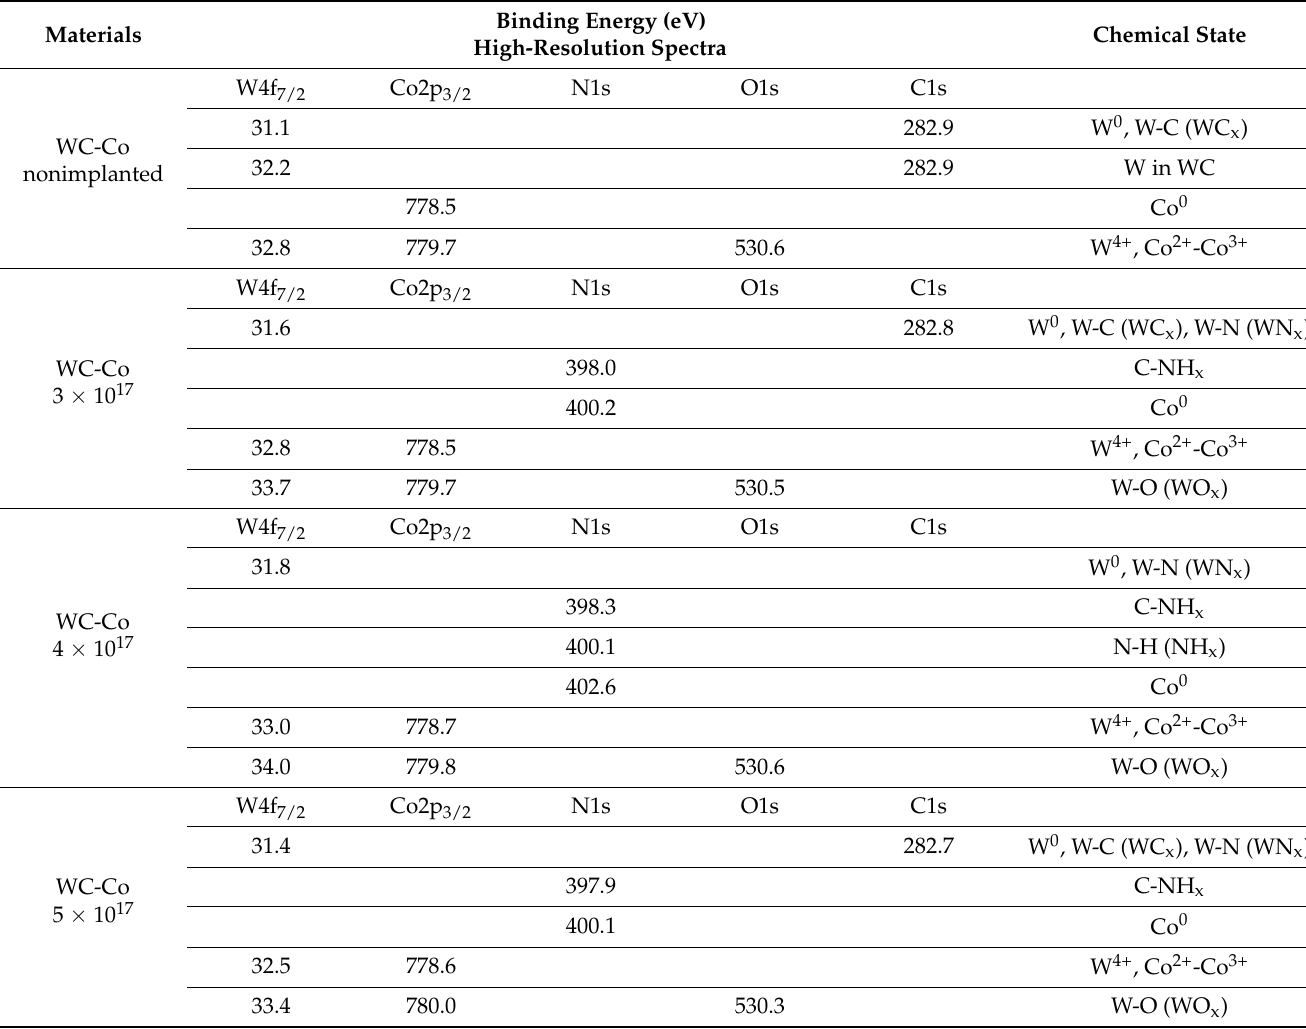
Table 1. W4f 7/2 , Co2p 3/2 , N1s and O1s binding energies evaluated from a deconvolution procedure of corrected